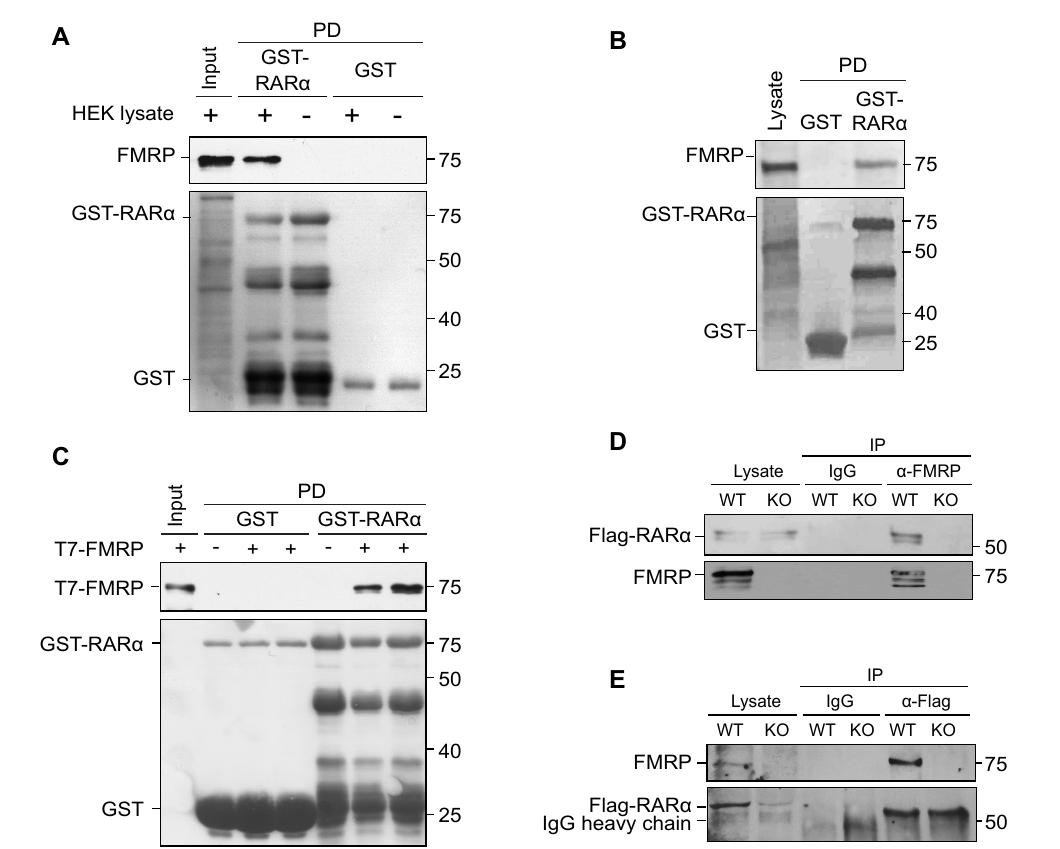
Figure 1. RAR α interacts directly with FMRP. ( A ) Pull-down of endogenous FMRP from HEK cell lysate by purified GST-RAR α coupled to Glutathione sepharose beads (top panel: FMRP immunoblot; bottom panel: Ponceau staining). Purified GST coupled to Glutathione sepharose beads was used as a negative control. ( B ) Pull-down of endogenous FMRP from P30 mouse hippocampal lysate by purified GST-RAR α coupled to Glutathione sepharose beads (top panel: FMRP immunoblot; bottom panel: Commassie staining). Purified GST coupled to Glutathione sepharose beads was used as a negative control. ( C ) In vitro pull-down of purified T7-FMRP by purified GST-RAR α but not GST (top panel: T7 immunoblot; lower panel: Ponceau stain). ( D , E ) Co-immunoprecipitation of endogenous FMRP with Flag-RAR α from DIV14-15 primary hippocampal neurons using anti-FMRP antibodies ( D ) and anti-Flag antibodies ( E ). In both experiments, lentivirus expressing Flag-RAR α -IRES-GFP-Cre in RAR α fl/fl background was used to replace endogenous RAR α with Flag-tagged RAR α . Hippocampal cultures obtained from RAR α ffl/fl / Fmr1 KO mice (KO) were used as negative controls for specificity of